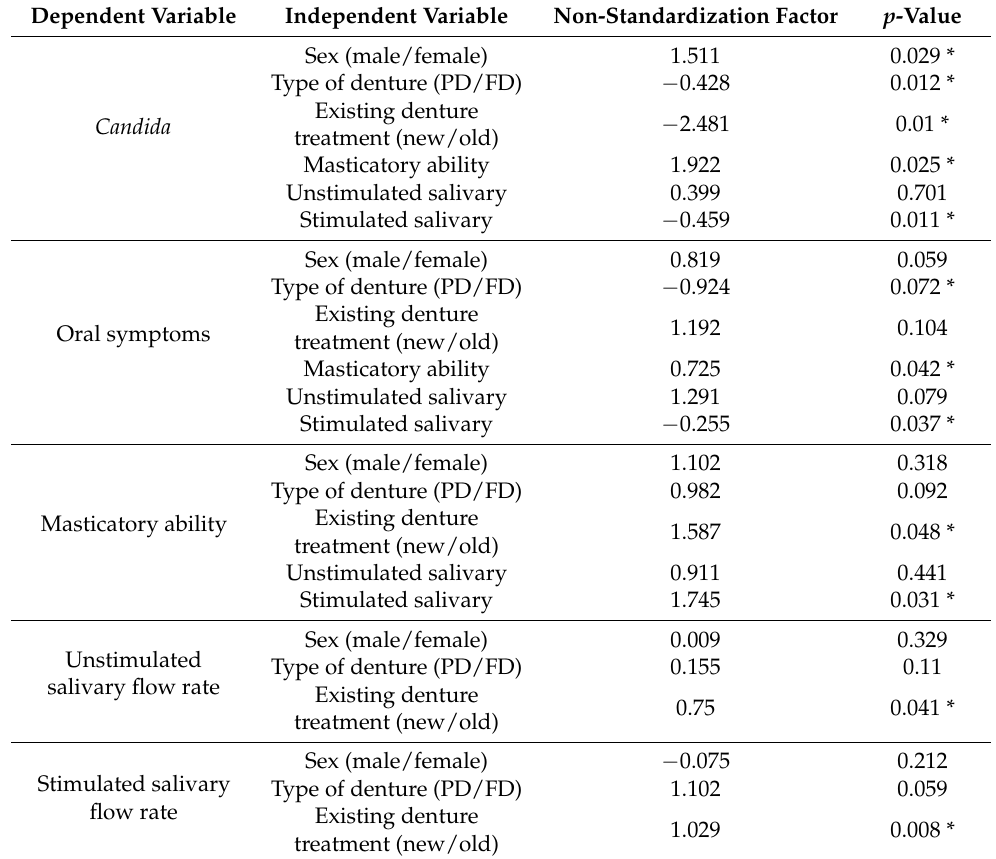
Table 2. Multiple regression